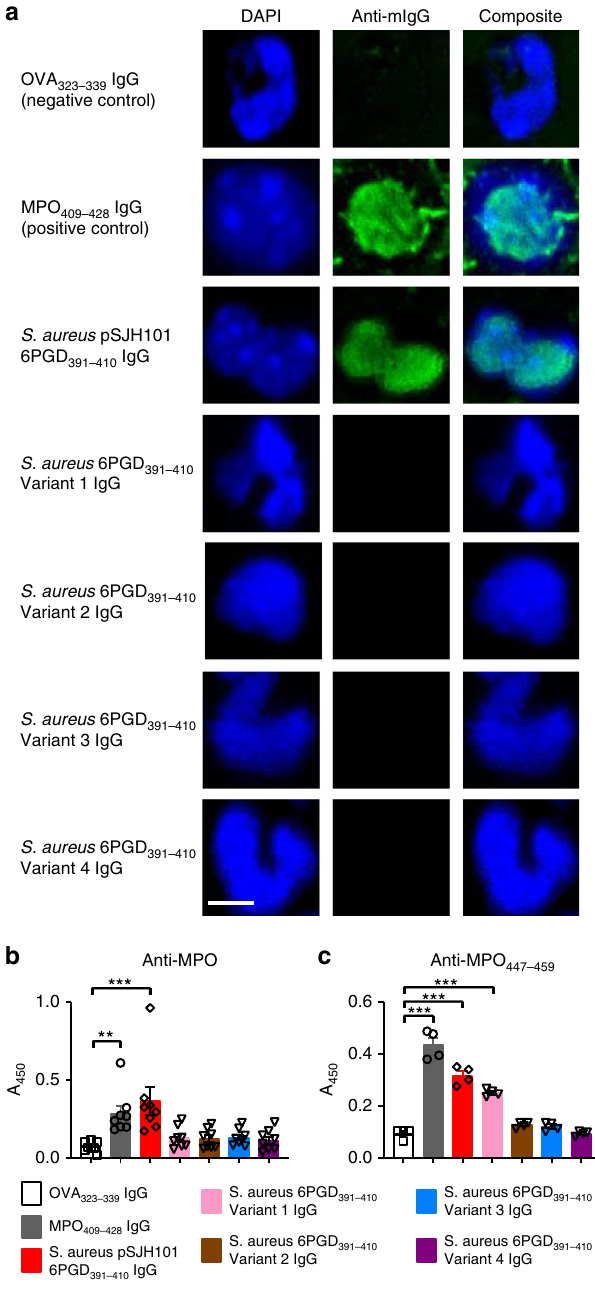
binding of MPO-ANCA to neutrophils by indirect immuno- fl uorescence, as there are known to be multiple B-cell epitopes in active MPO-AAV 34 .